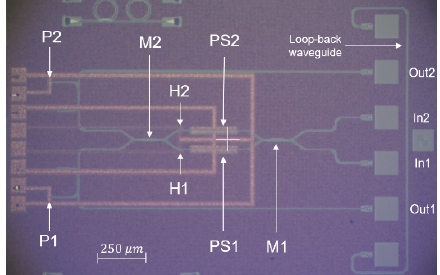
Figure 8. Image of 2 × 2 MZI circuit: M1 and M2 are 3-dB MMI couplers; the phase shifters (PS1 and PS2) are commonly grounded and symmetrically integrated; H1 and H2 are the heaters, P1 and P2 are the photodetectors.